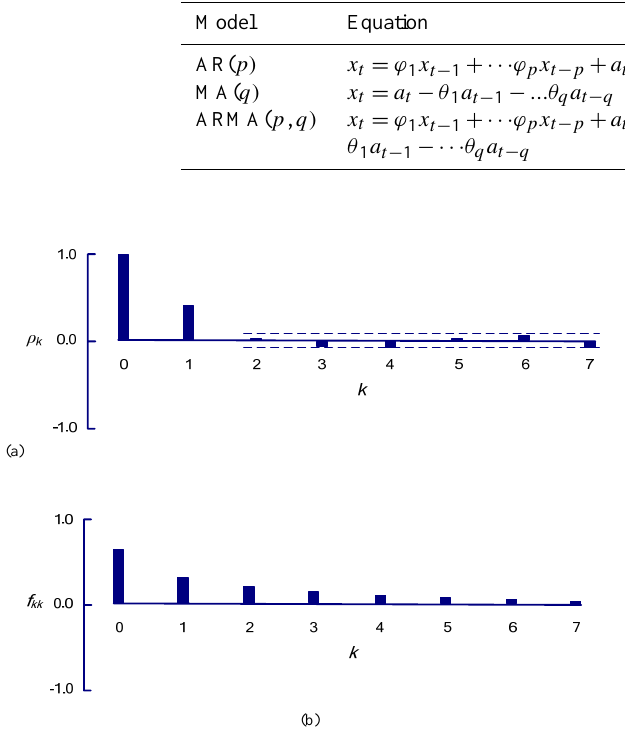
Fig. A1. Parameters of an assumed time series: (a) autocorrelation function, (b) partial autocorrelation function.